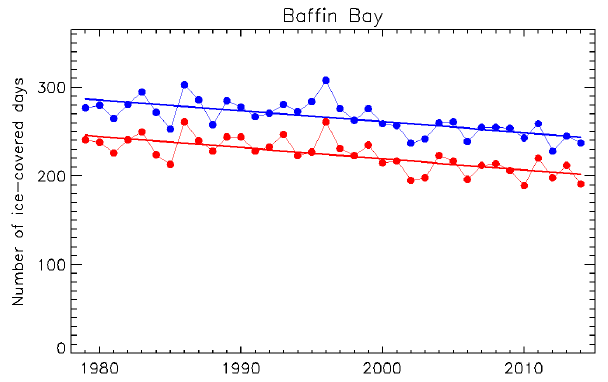
Figure 8. Number of ice-covered days in Baffin Bay (all depths), 1979–2014, based on two thresholds: 15% (blue) and 50% (red) (see also Fig. 7). Least-squares lines are also shown. See Fig. S5 for similar plots for other